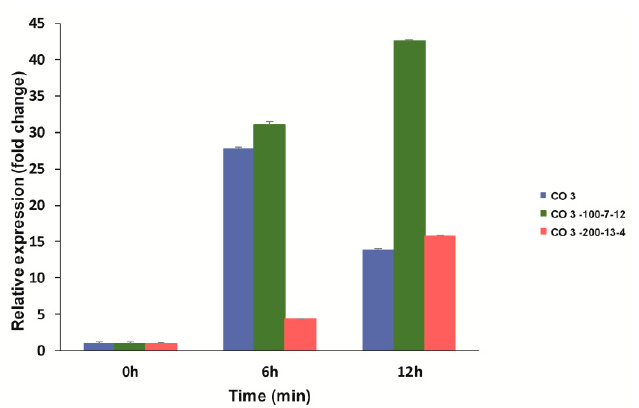
Figure 8. Relative expression profile of pyruvate, orthophosphate dikinase (PPDK) gene analyzed using qRT-PCR under dehydration stress for 0 h (control), 6 h (early) and 2 h (late) in 21 day-old seedlings of CO 3, CO 3-100-7-12, and CO 3-200-13-4. The relative expression ratio of each gene was calculated relative to its expression in control sample (0 h). SiAct2 was used as an internal control to normalize the data. Error bars representing standard deviation were calculated based on three technical replicates for each biological